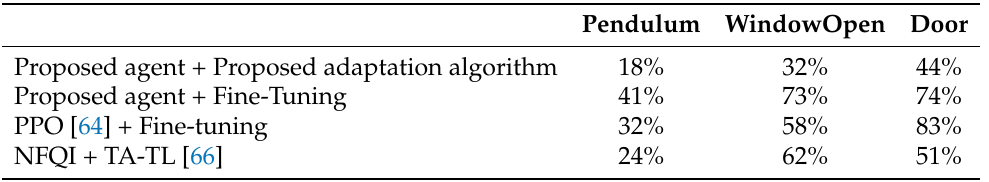
Table 5. The performance of the proposed agent on source tasks after adaptation. These scores represent the deterioration in success rate compared to the one before the adaptation.